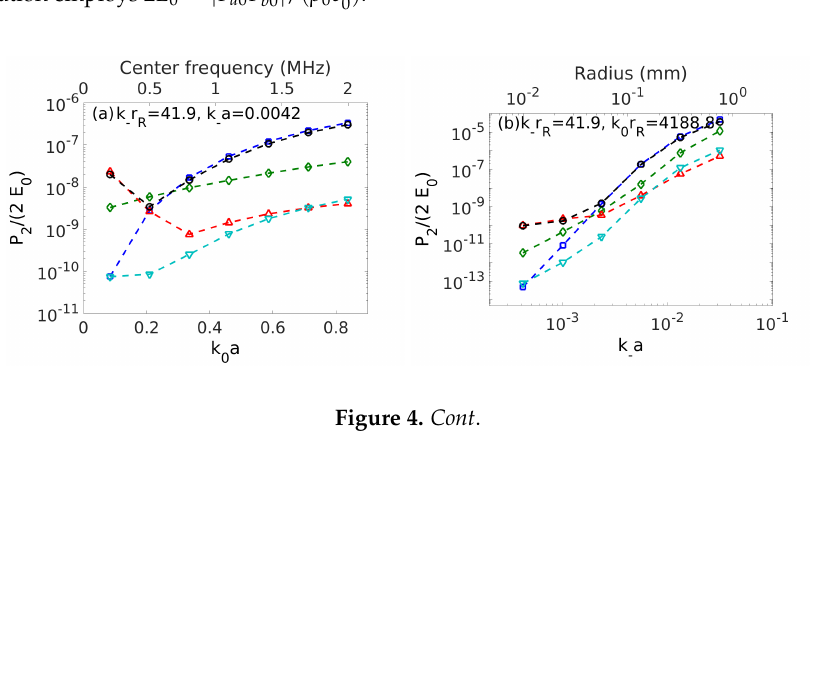
Figure 3. A rigid immovable sphere with collinear incident waves propagating at ˆ i z . The difference frequency component of p 2 is calculated at r R = − r R ˆ i z as a function of ( a ) center frequency or k 0 a , ( b ) object radius or k − a , ( c ) receiver range or k 0 r R and ( d ) difference frequency or k − r R . The lower dimensionless abscissas are for general interpretations. The upper abscissas are for a medical or underwater sensing example with 1 MHz primary and 10 kHz difference frequencies, 0.1 mm sphere radius at range 1 m from the receiver with 1500 m/s sound speed. In ( a ), p SS dominates for large k 0 a , while p IS + p SI dominates for small k 0 a . In ( b ), p SS dominates for large k − a , p IS + p SI dominates for small k − a . In ( c ), p SS is dominant and has the most gradual roll-off with range. In ( d ), p SS dominates for small k − r R while p IS + p SI dominates for large k − r R . The nonlinear parameter is β = 3.6. The